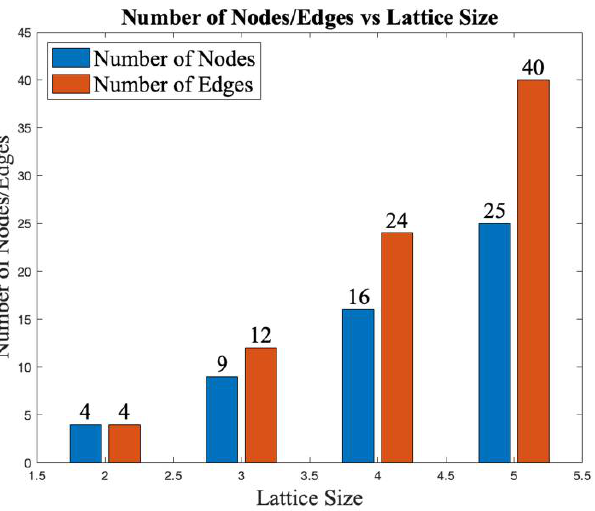
Figure 5. Number of nodes/edges as a function of lattice sizes.